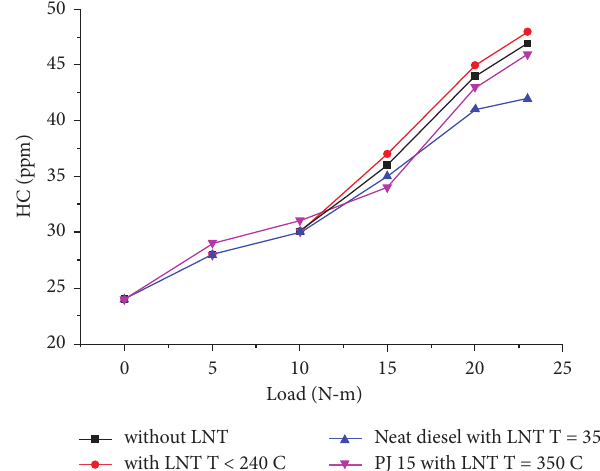
Figure 15: HC emission for Diesel and PJ15 with